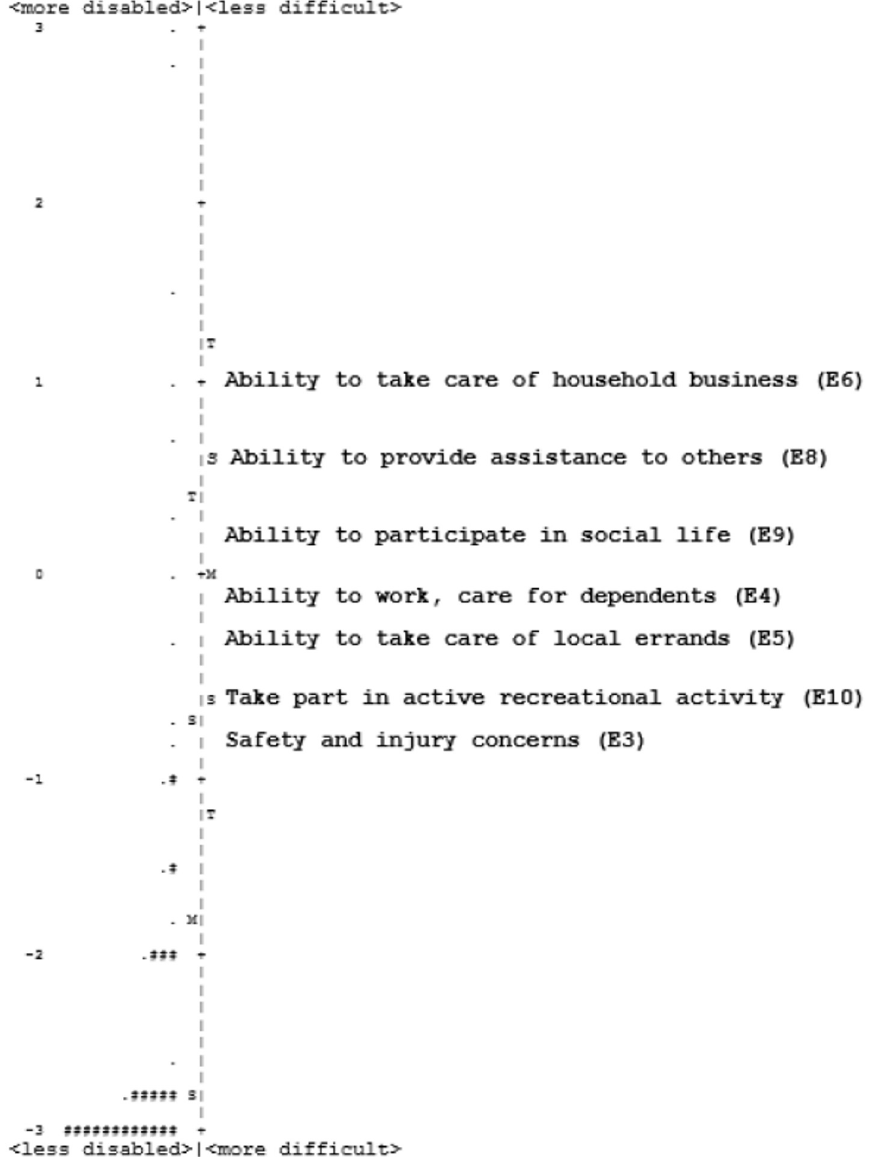
Fig 4. Person-item map for eCAPS. Respondents are shown on the left side of the dashed line and items are shown on the right side. Respondents who are less disabled (have higher visual function) and items that are more difficult (respondents are more likely to rate having greater difficulties with tasks) are located at the bottom. Each ‘#’ represents 12 respondents and each ‘.’ represents 1–11 respondents. M = mean, S = 1 standard deviation, T = 2 standard deviations. The scale is in